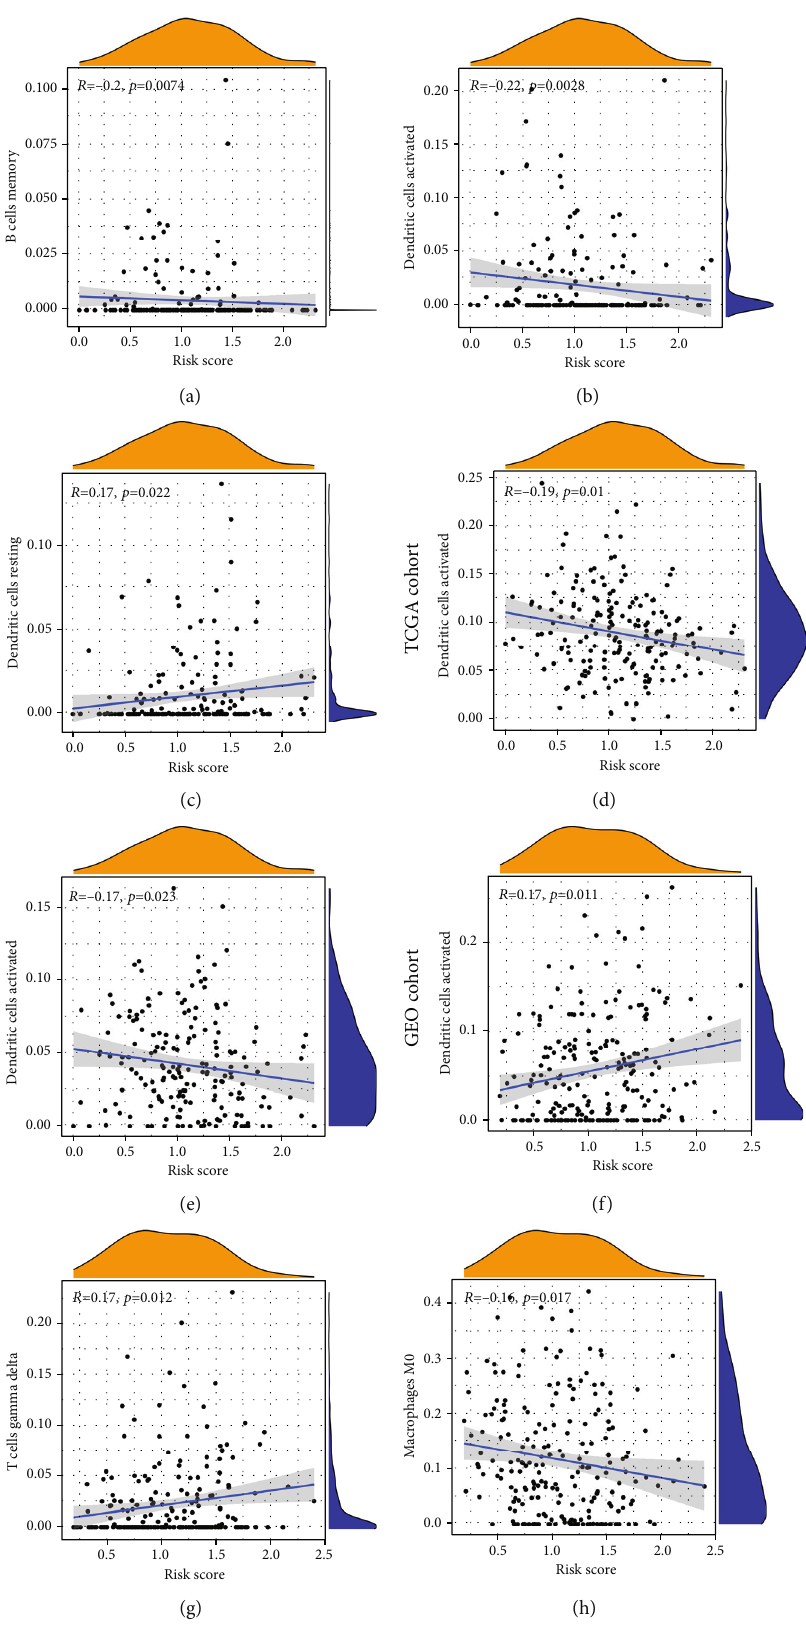
Figure 6: Correlation analysis of the risk score with in fi ltration abundances of several immune cells in TCGA cohorts (a – e) and GEO (f – h)